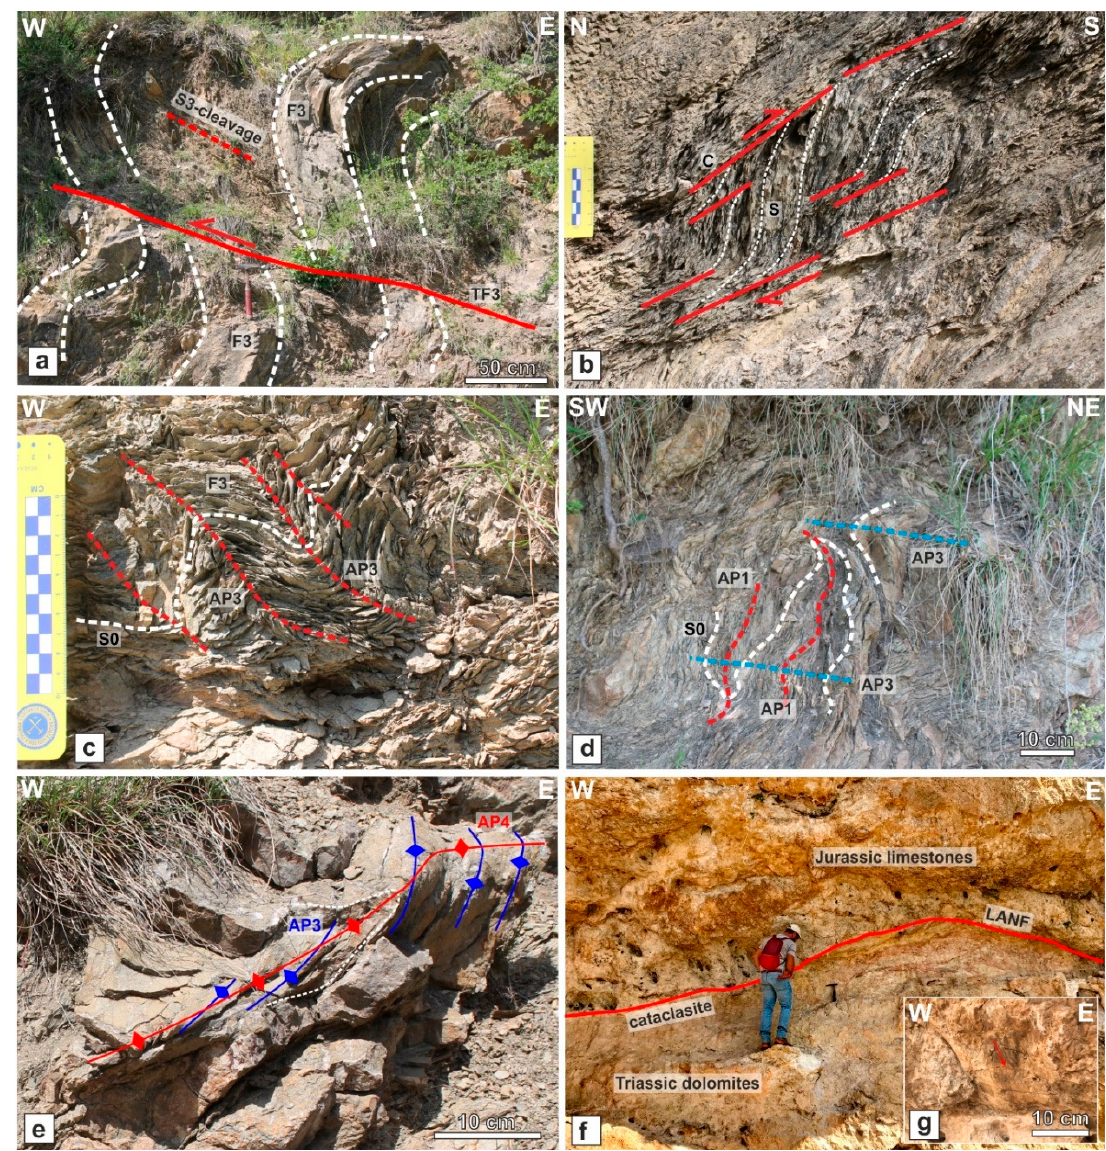
Figure 8. Campagna tectonic window (Acerno-Tusciano River). Mt Croce unit: ( a ) thrust fault (TF4) verging to SW with associated anticline and syncline in the hanging wall and footwall, respectively; ( b ) shear zone located in the footwall of a TF4 with S-C structures (S is the tectonic cleavage S1 associated to the D1 deformation); ( c ) F3 folds verging to W. Interference pattern between F3 and F4 folds: ( d ) type 3; ( e ) type 2. ( f ) Low-angle normal fault (LANF) located between Triassic dolomites (footwall) and Jurassic limestones (hanging wall) of the Apennine Platform (Ripe di Pappamondo). ( g ) Particulars of the LANF of the previous image, showing the gently dipping fault plane with slickenside striations.